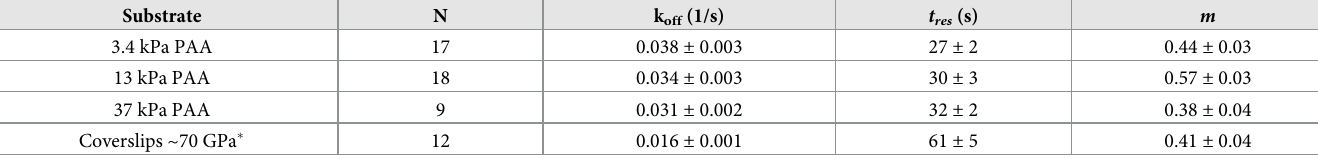
, and mobile fraction, m , determined by fitting FRAP recovery curve by Eq 7, obtained from N experiments. The characteristic Average unbinding constant for zyxin, k off time, t res , was obtained from k off (Eq 8). Errors are SE. � Data reported in a previous work, Sigaut et al ., 2018